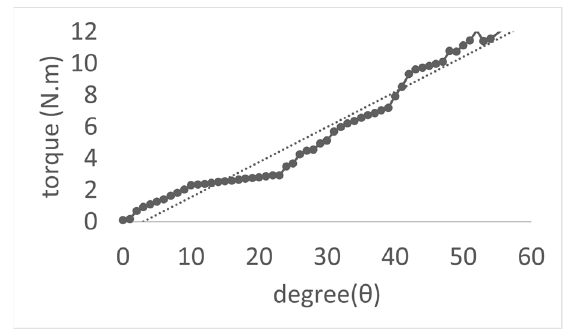
Figure 8. Linear regression for the torque of the PULE.